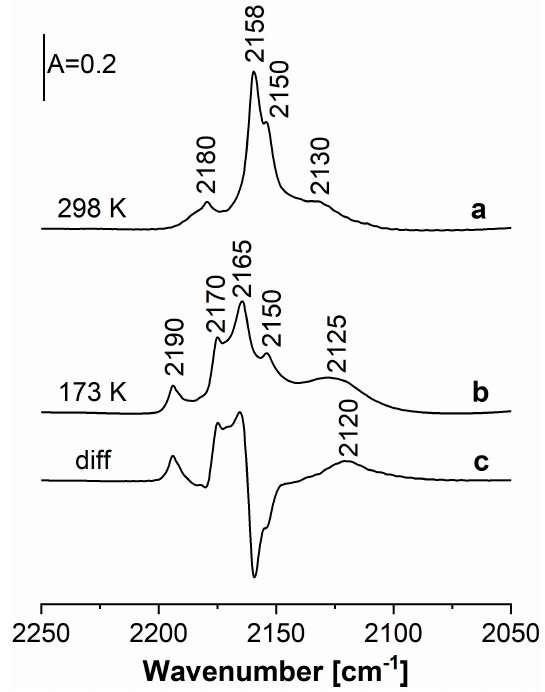
Figure 4. The spectra recorded upon the sorption of CO in the Cu(5)HFAU zeolite at room temperature ( a ), at 170 K ( b ), and difference spectrum ( c = b – a ).